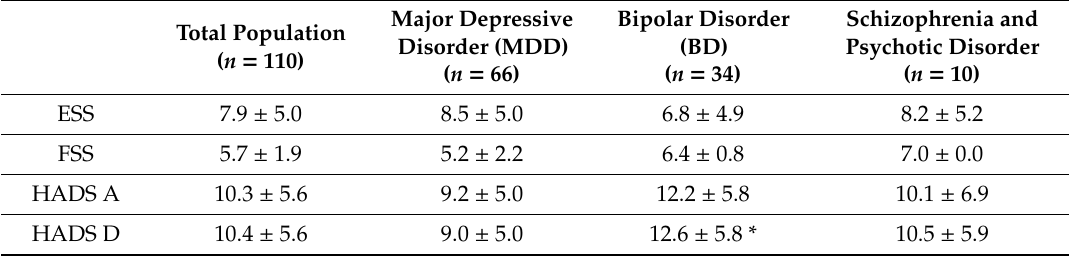
Table 2. Epworth Sleepiness Scale (ESS), Fatigue Severity Scale (FSS), and Hospital Anxiety and Depression Scale (HADS) of the study groups (mean ±